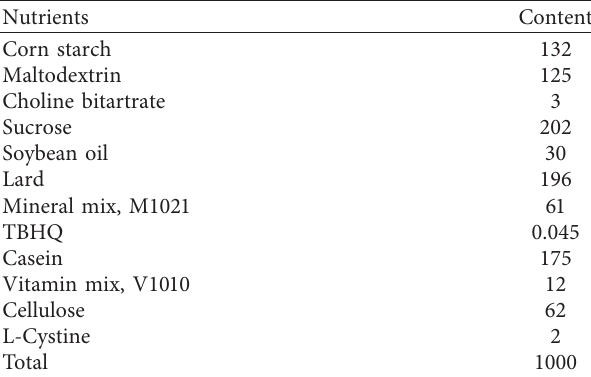
Table 2: Composition of nutrients of high-fat